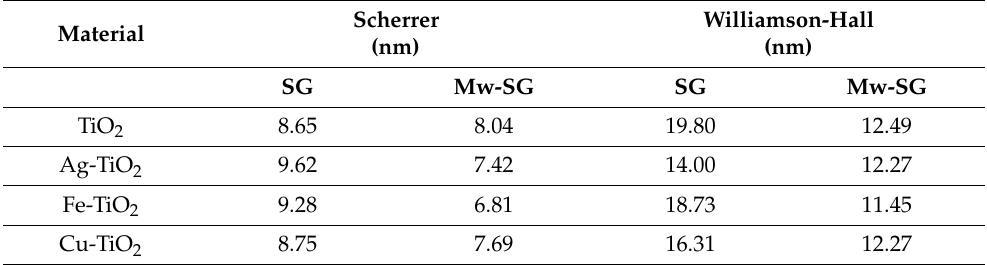
Figure 3. X-ray diffraction patterns of ( a ) SG-synthesized and ( b ) Mw-SG-synthesized materials.